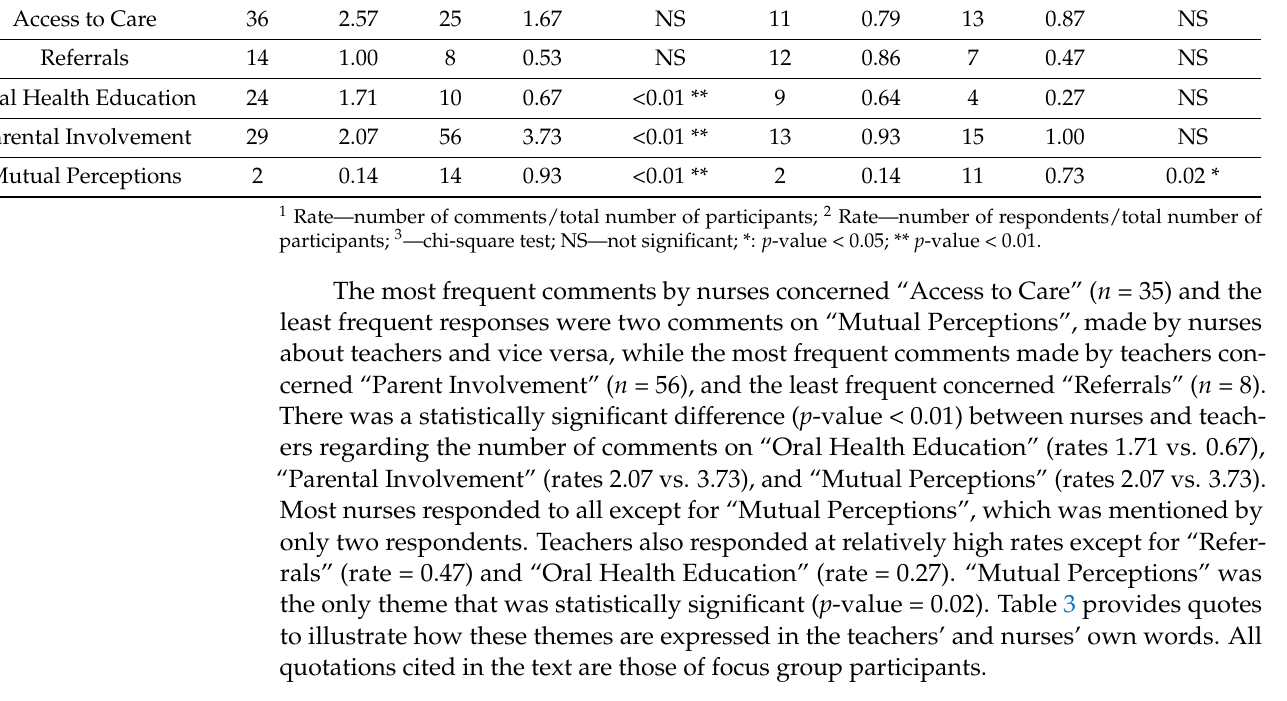
Table 3. Representative comments for key